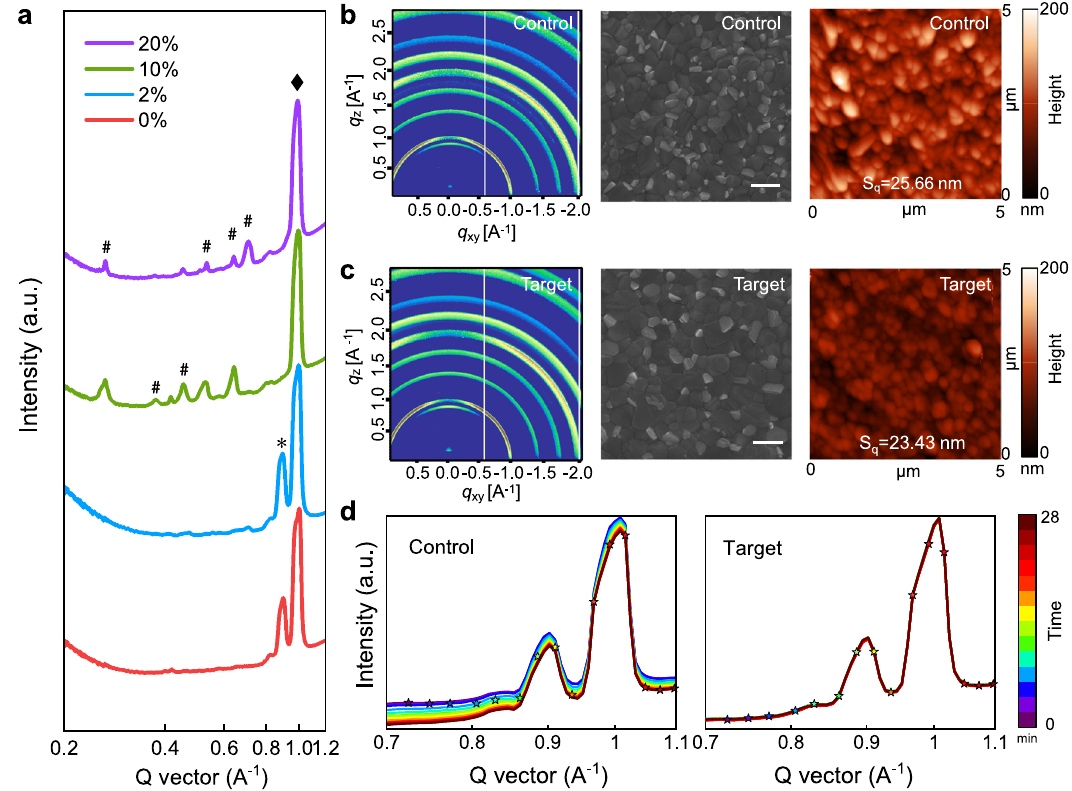
Fig. 3 Crystal structure and morphology. a The grazing-incidence X-ray diffraction (GIXD) pro fi les of perovskite fi lms with different K + concentrations. The peaks labeled by “ diamond ” , “ asterisk ” , and “ hash ” are ascribed to bication perovskite, PbI 2 , and K x Pb y I z Br (x + 2y − z) , respectively. b , c Grazing-incidence wide-angle X-ray scattering (GIWAXS) maps, top-view scanning electron microscopy (SEM) images and atomic force microscopy (AFM) images of the control ( b ) and target ( c ) perovskite fi lms. Scale bar, 500 nm. d In situ time-resolved GIXD patterns under 530-nm light illumination of the control and target perovskite fi lms in the characteristic Q vector